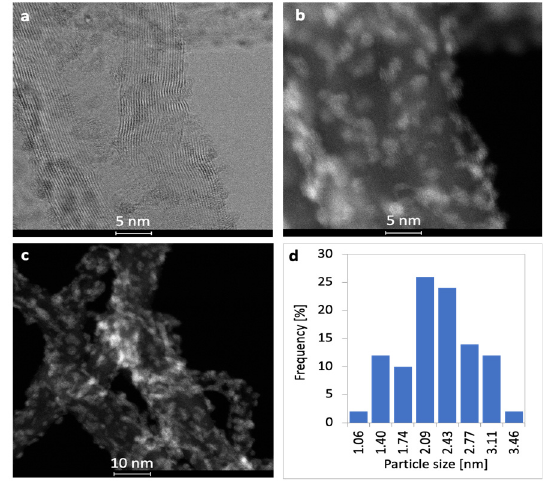
Figure 4. Bright field ( a ) and dark field ( b , c ) TEM pictures of NiCZ/CNT with Ni-CeZrO 2 particle size distribution ( d ).